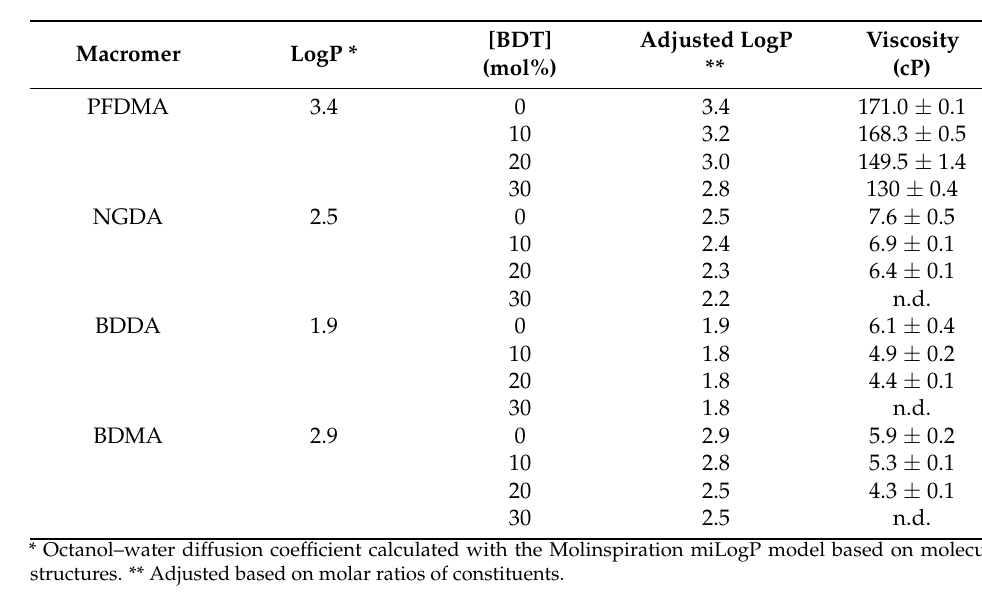
Table 3. Organic phase viscosity of PFDMA, NGDA, BDDA, and BDMA diluted with BDT at varying concentrations. Viscosity values at 30% BDT for NGDA, BDMA and BDDA were not measurable. (Not determined = n.d.).